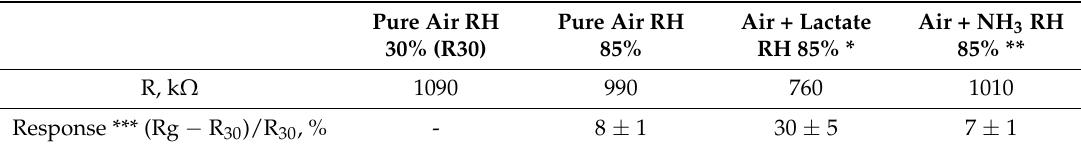
Table 1. Cross-sensitivity of the sensor based on spark-discharge-synthesized tin dioxide to some physiologically important gases at temperatures taken for the measurements of hydrogen response of the sensor (450 ◦